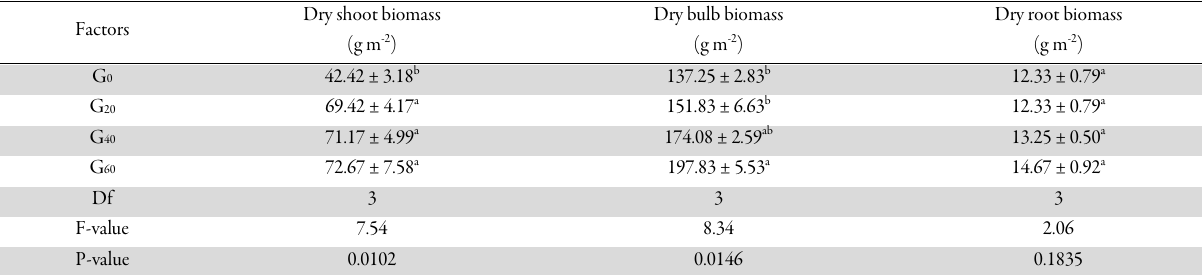
Table 3. Influence of various doses of GA 3 on dry biomass accumulation in onion shoots, bulbs and roots Factors